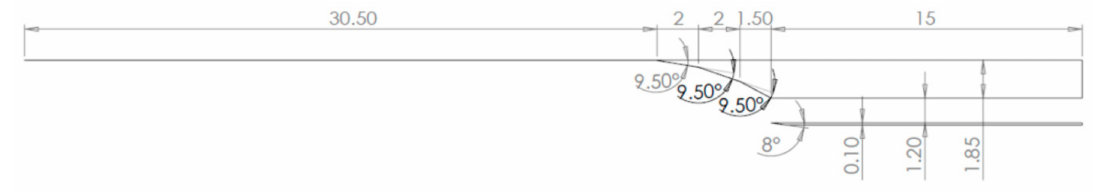
Figure A3. Three ramp inlet schematic (dimensions in metres).